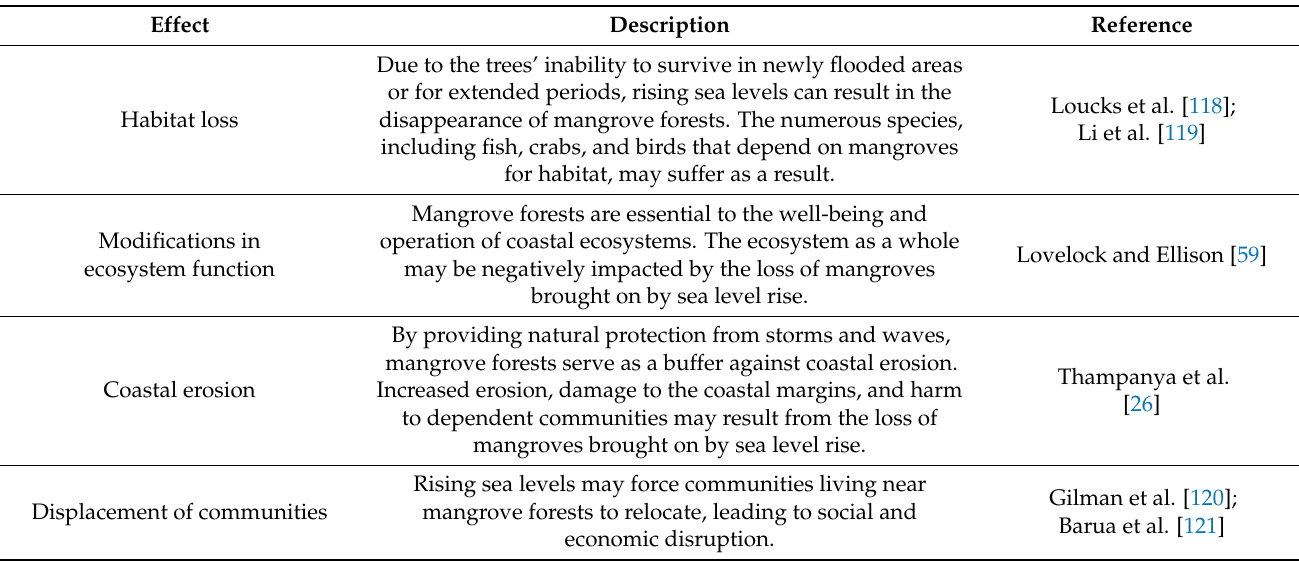
Table 10. Effects of sea-level rise on mangrove